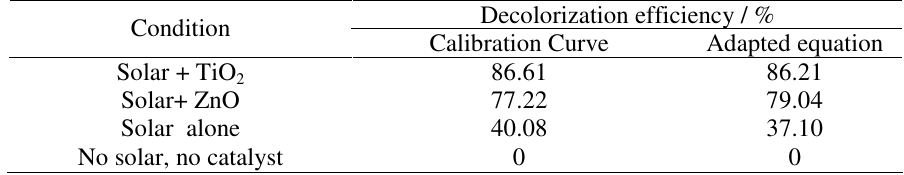
Table 1 . Comparison between decolorization efficiency obtained from the calibration curve and the adapted